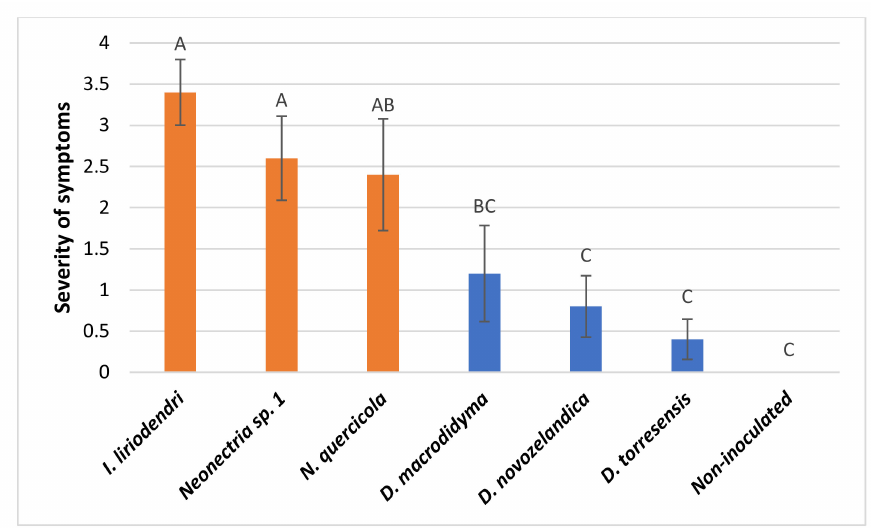
Figure 5. Severity of internal symptoms in ‘Lauranne’ almonds grafted onto ‘GxN-15’ inoculated with Ilyonectria liriodendri AL79 isolate; Neonectria quercicola AL141 isolate; Neonectria sp. 1 AL77 isolate; Dactylonectria macrodidyma AL150 isolate; D. novozelandica AL84 isolate; D. torresensis AL29 isolate. Non-inoculated plants were used as controls. Potted plants were maintained in greenhouse conditions and evaluations were performed 5 months after inoculation. Results are the mean of ten plants per isolate and error bars correspond to the standard error. Data were subjected to analysis of variance (ANOVA) and different letters above bars indicate significant differences according to LSD test at p < 0.05.